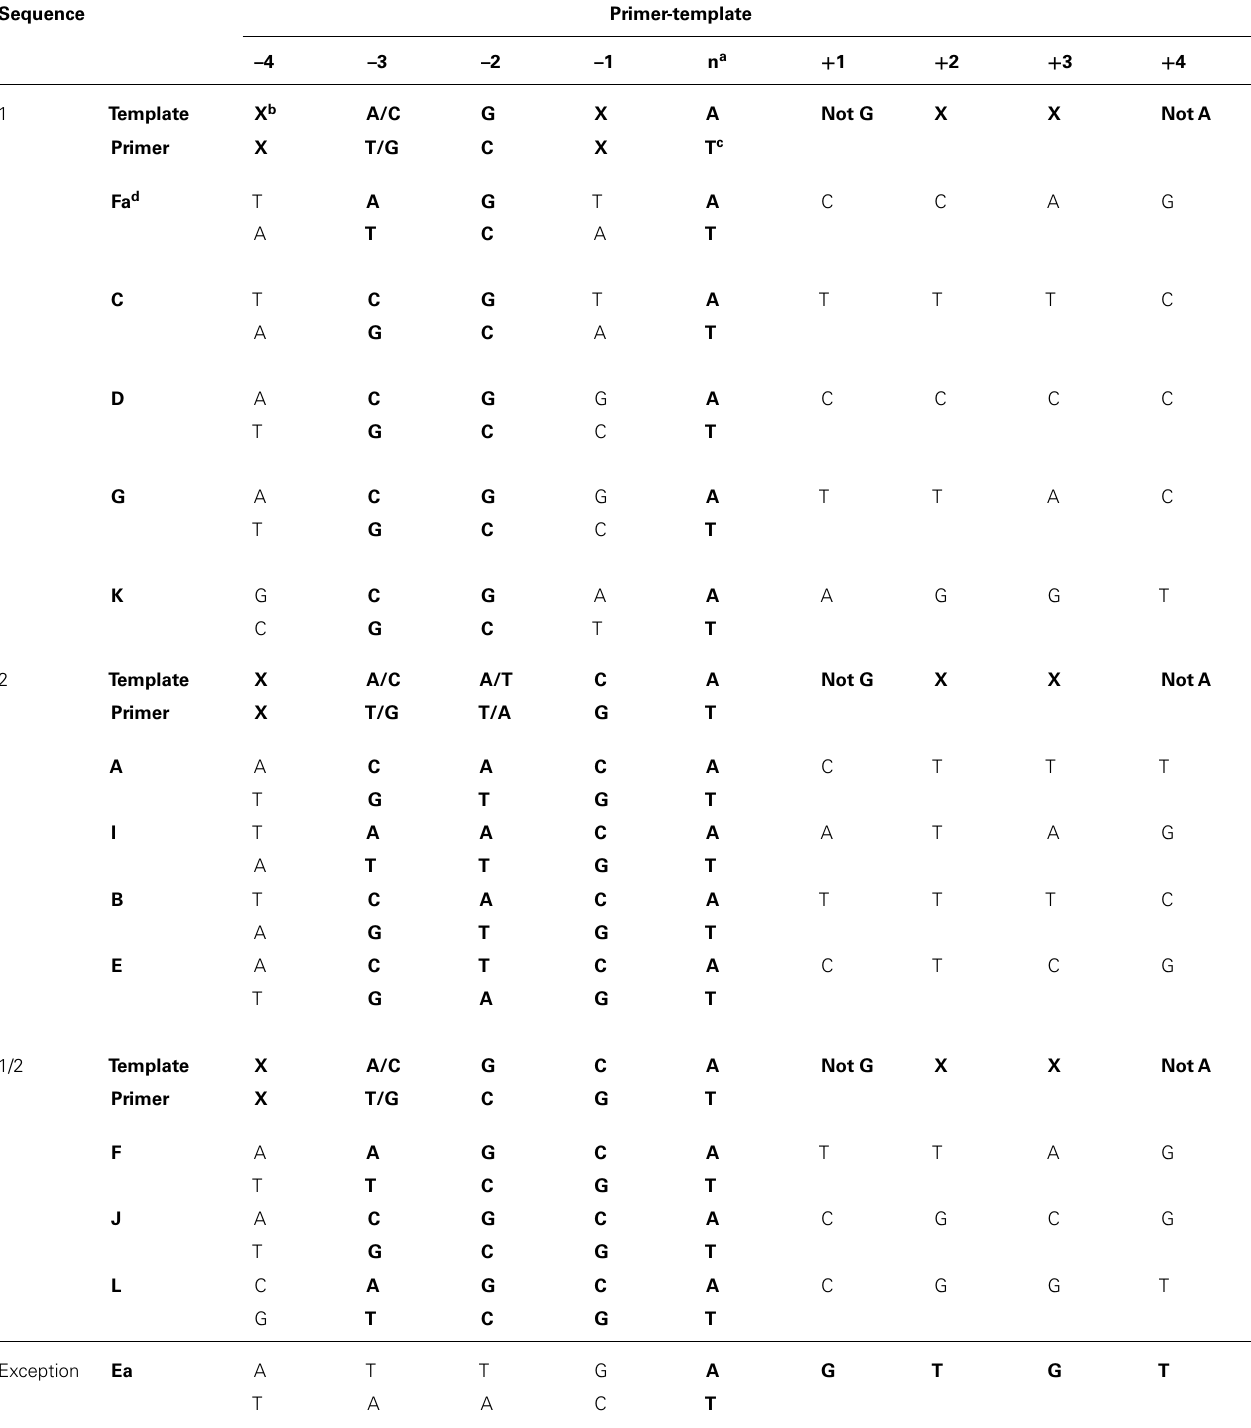
Table 3 | DNA sequences that promote pyrophosphorolysis by the phageT4 L412M-DNA polymerase.